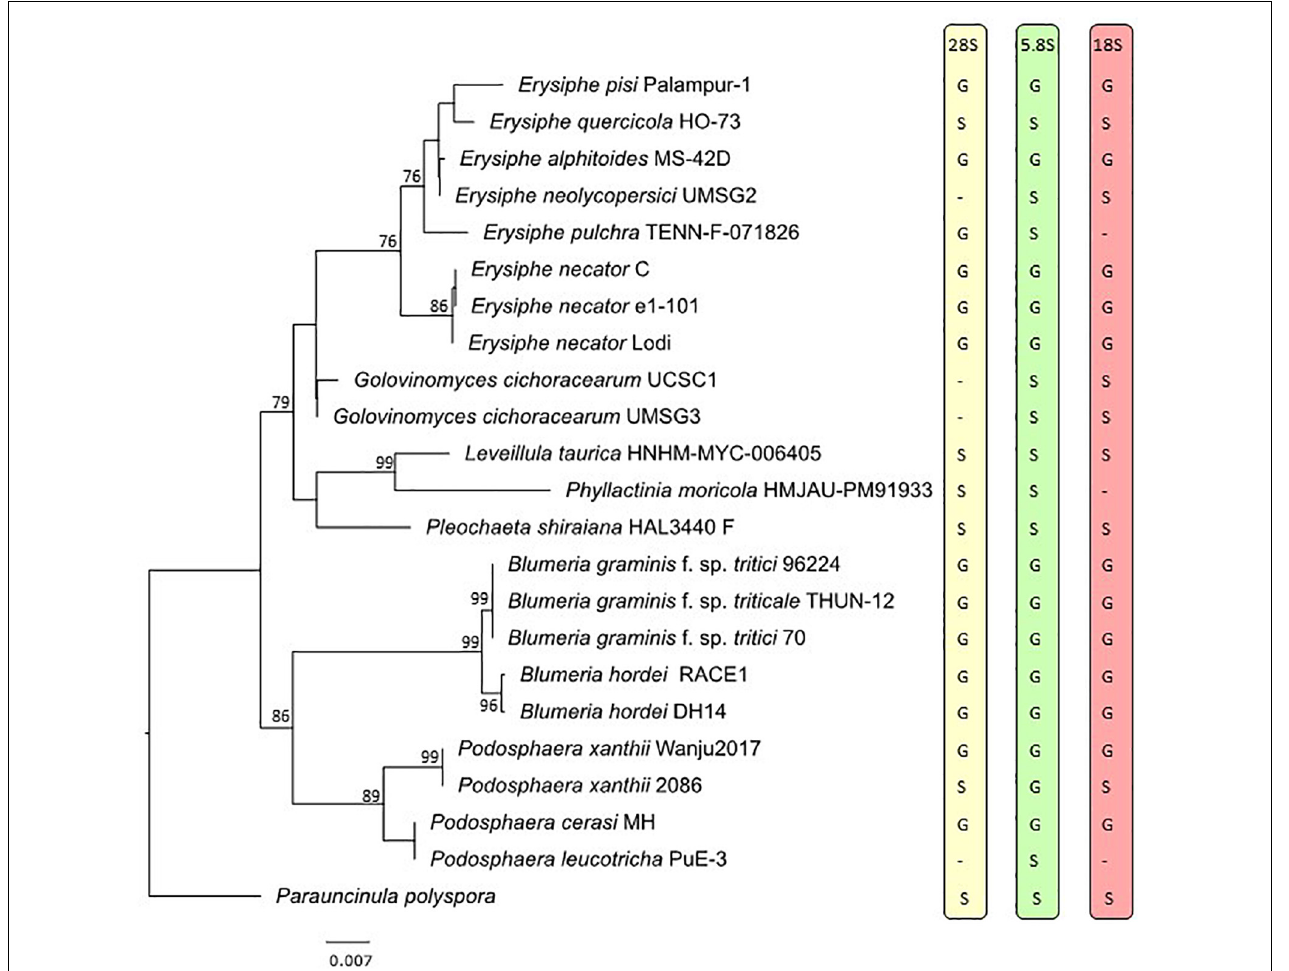
FIGURE 2 | Maximum likelihood phylogeny based on the concatenated sequences of the 5.8S, 18S, and 28S regions of the nuclear ribosomal DNA of representative powdery mildew taxa. Bootstrap values greater than 70% are shown above or below the branches. The tree is rooted to Parauncinula polyspora specimen sequenced by Frantzeskakis et al. (2019a). Taxon labels include species names followed by the specimen accession numbers, except for Parauncinula polyspora , for which a herbarium specimen is not available (Frantzeskakis et al., 2019a). The letters on the right side of the tree indicate source of the 28S, 5.8S, and 18S nrDNA sequences as G (extracted from the genome) or S (produced through Sanger sequencing or obtained from NCBI GenBank database). Dashes indicate missing loci. The scale bar represents nucleotide substitutions per